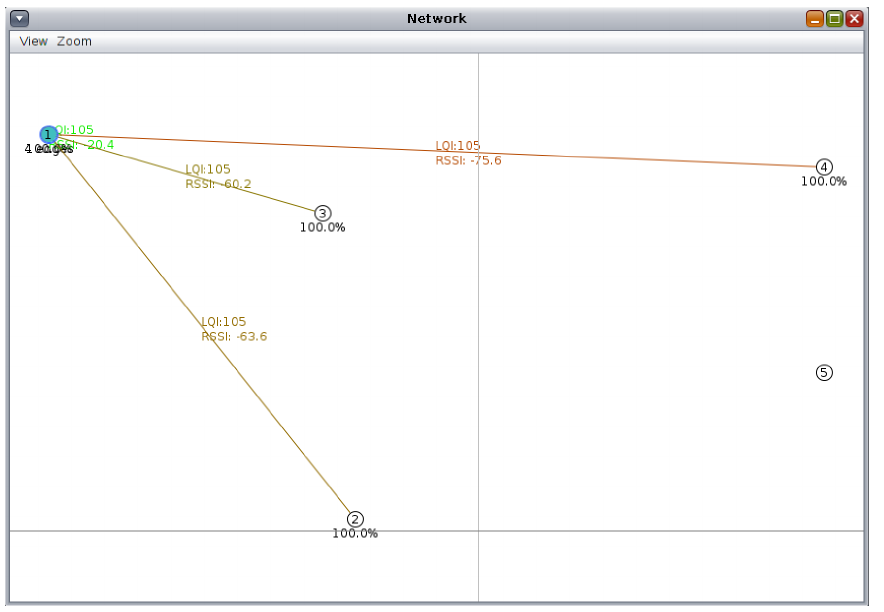
Figure 6. Cooja-TruNET interconnected simulation: WSN